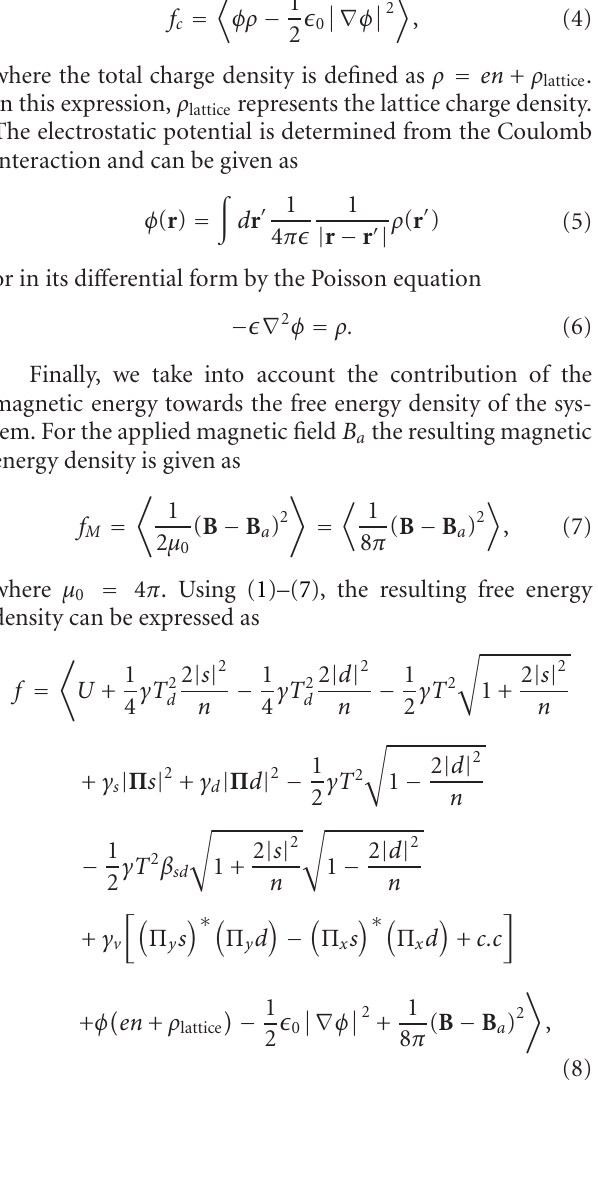
Figure 1: Variation of relative magnitude of d - and s -wave order parameter components (cid:5) ω d (cid:6) / (cid:5) ω s (cid:6) with the coupling parameter β sd at di ff erent magnetic field inductions b . Other relevant parameters are t = T/T d = 0 . 5, κ = 72, γ v /γ d = (cid:2) v = 0 .